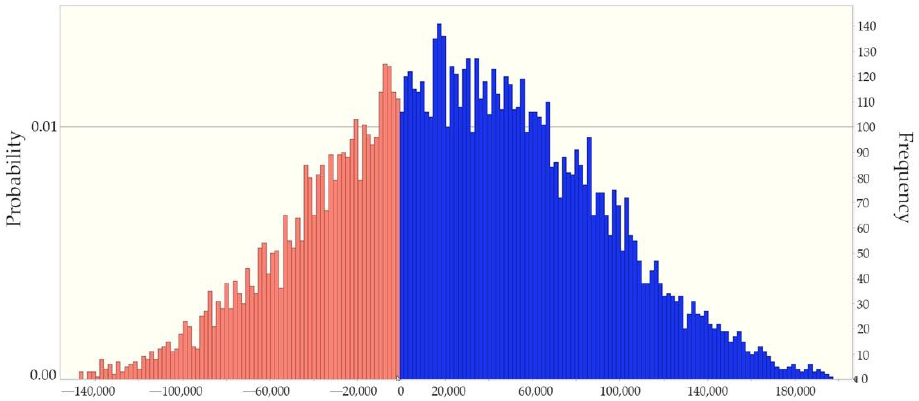
Figure 7. Monte Carlo simulation: probability/frequency chart of impact during peak hours in